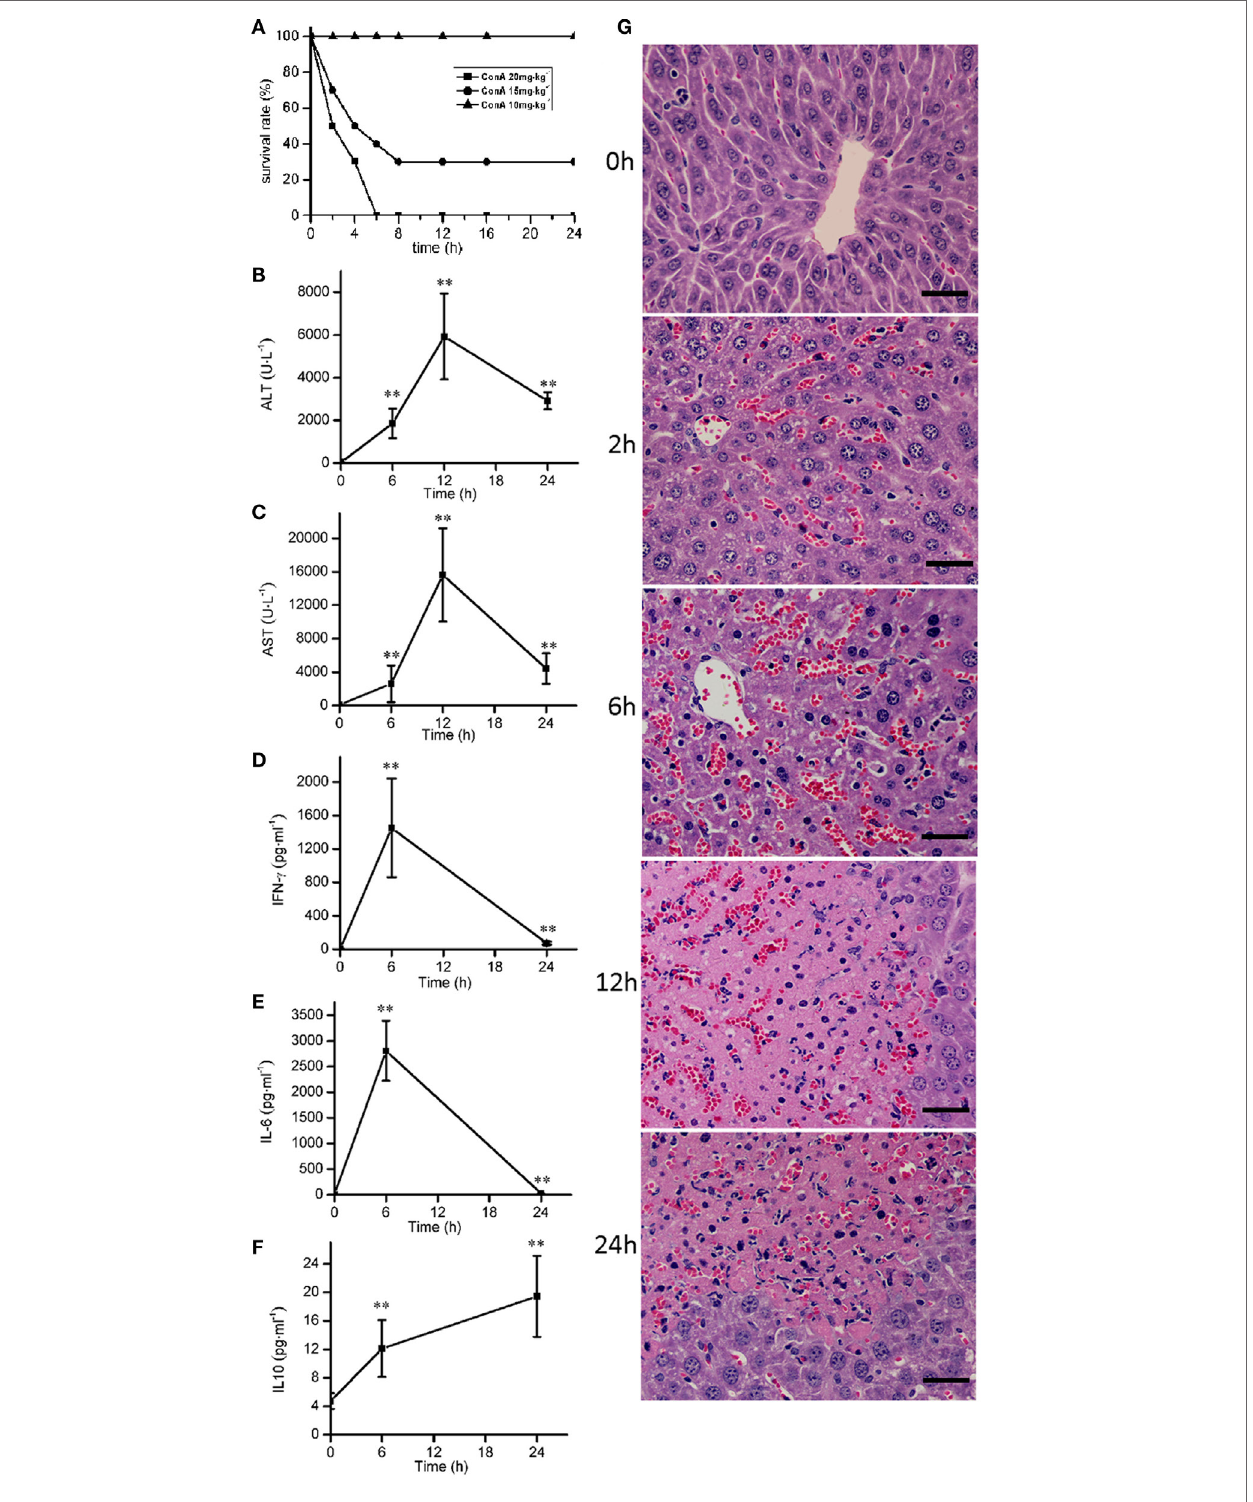
FigUre 1 | The time course of pathological, blood chemical, and cytokine changes in ConA-induced hepatitis. (a) The survival rates were decreased with the increase of ConA. (B,c) The serum levels of alanine transaminase, aspartate transaminase after ConA (10 mg ⋅ kg − 1 ) administration. (D–F) The changes of serum levels of IFN- γ , IL-6, and IL-10 after ConA (10 mg ⋅ kg − 1 ) administration. (g) Representative micrographs depicting H&E stained hepatic sections observed under 40 × objectives after ConA (10 mg ⋅ kg − 1 ) administration. Scale bars, 50 µm. Mice were administered with a single intravenous injection of saline containing ConA. The mice treated with intravenous injection of normal saline only were used as control (time 0 h). Error bars indicate mean ± SD. ** P < 0.01 compared with control group ( n = 6).